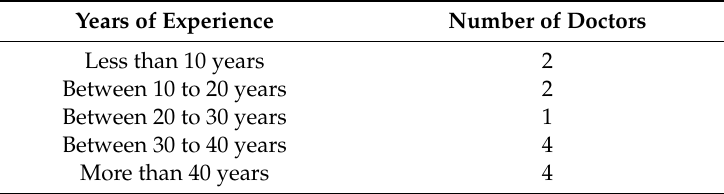
Table 2. Physicians’ experience in the field of women’s health.